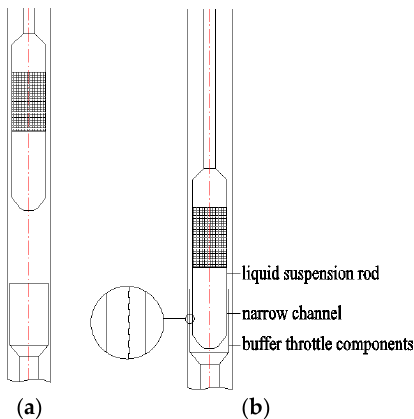
Figure 1. Schematic diagram of liquid-suspended shutdown assembly. ( a ) The normal working position; ( b ) Unprotected loss of flow accident.